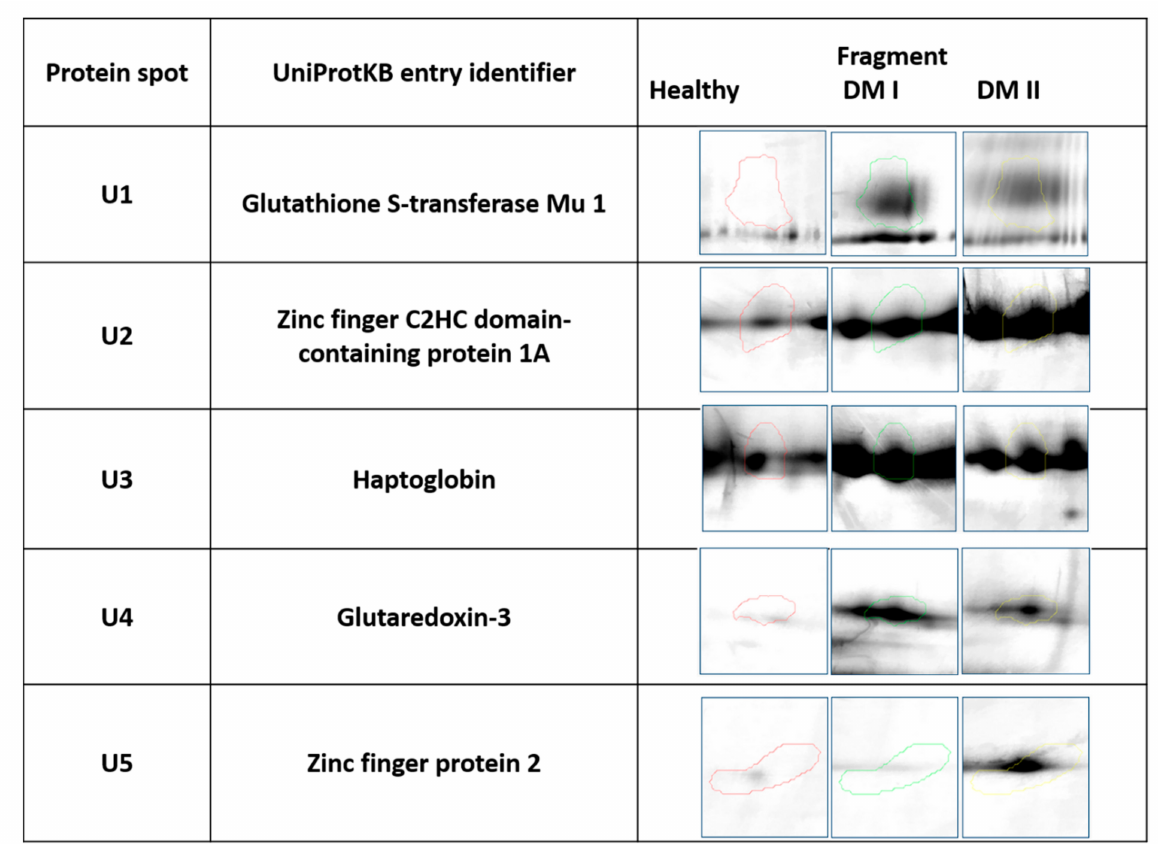
Figure 1. Statistically significant ( p ≤ 0.05) representatives of 2DE gel spots in the diabetic groups compared to control group as revealed by the Delta2D software. Protein spots form Healthy group are marked in red, protein spot from DM I group are marked in green, Protein spots from DM II group are marked in